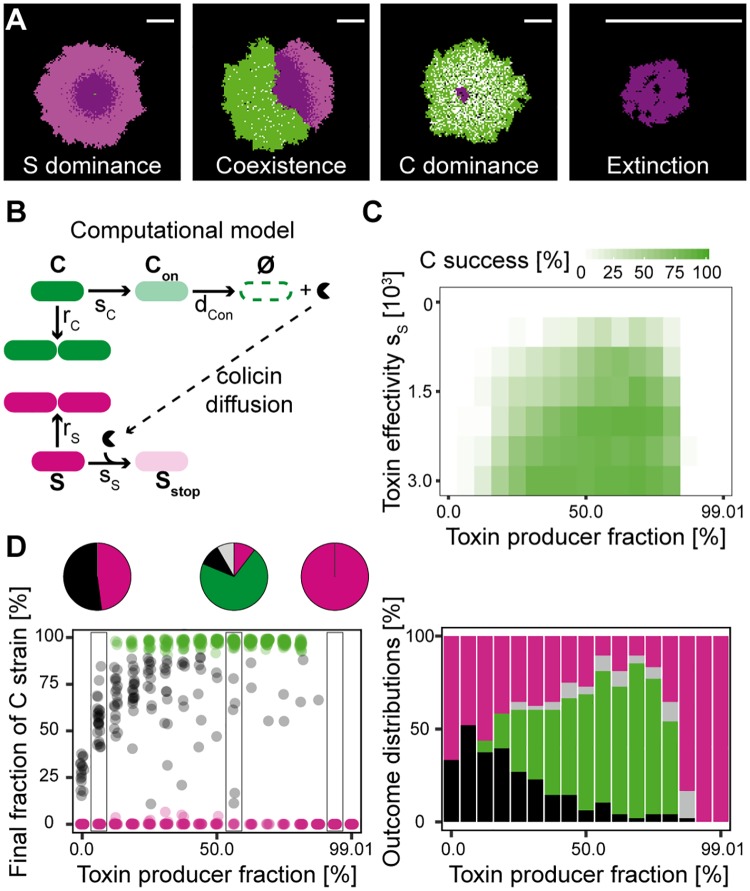
Theoretical analysis emphasizes the importance of intermediate toxin producer fractions for ColicinE2 producer strain (C strain) success.(A) The four different competition outcomes in simulations (bright magenta: living S cells, dark magenta: growth-inhibited S cells, green: reproducing C cells, white: toxin-producing C cells). Scale bar = 1 mm. Values of the switching rate sC from left to right: 0.001/0.02/0.001622/synchronicity scenario I. (B) The interaction scheme underlying the theoretical model (Methods). (C) C dominance phase diagrams for toxin effectivity sS and toxin producer fraction. (D) The final fraction of the C strain (dot plot) and classified outcomes (pie and bar plots) after simulated competition at fixed sS = 1,500 and in dependence on toxin producer fractions are in accordance with experimental results (Fig 1C). The color code represents competition outcome and is identical to that in Fig 1C.